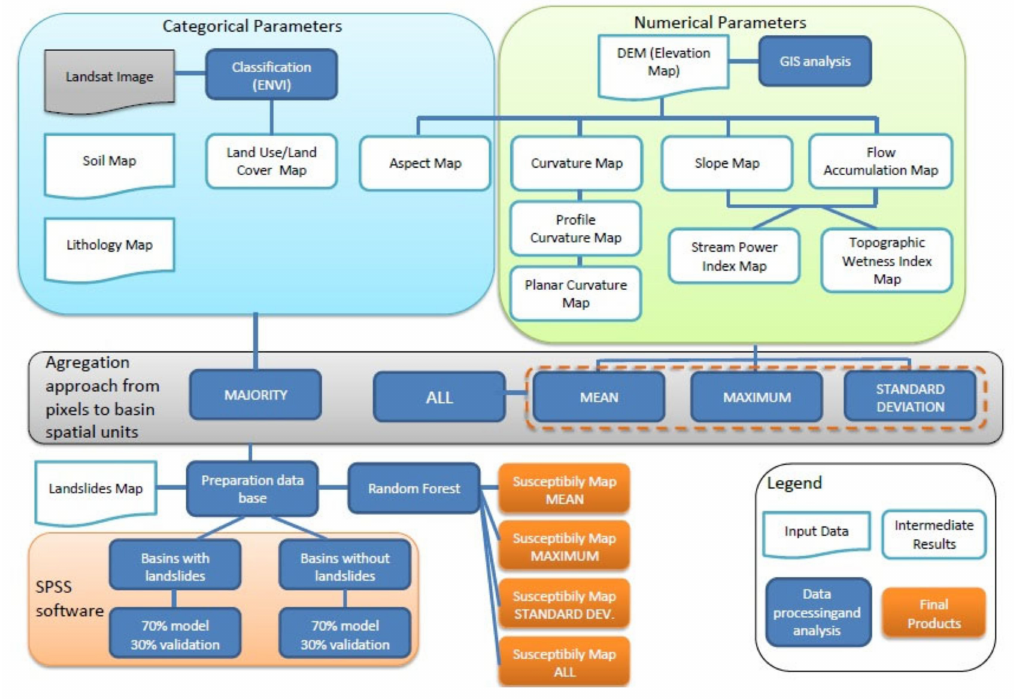
Figure 2. Workflow showing the main steps of the